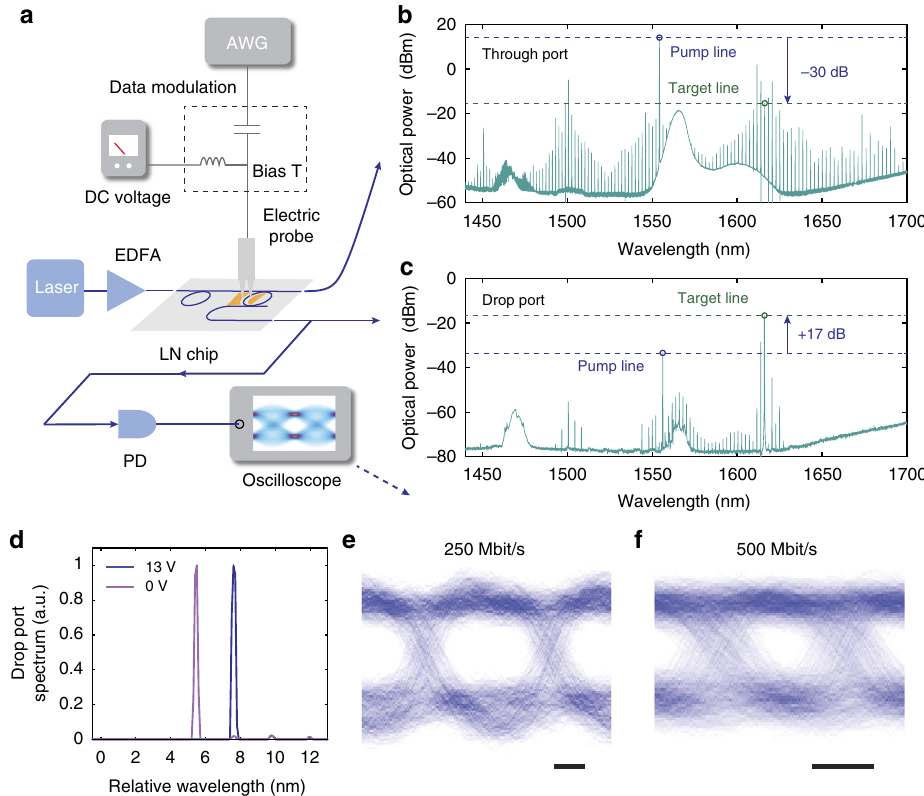
Fig. 3 On-chip fi ltering and modulation of a frequency comb. a Simpli fi ed characterisation setup. b , c Measured optical spectra at the through ( b ) and the drop ( c ) ports of the fi lter, picking out a target comb line at ~1616nm. The fi lter shows 47 dB suppression of the pump light. d Zoom-in view of the drop- port output spectra near the target line at different DC bias voltages. Applying a bias voltage of 13 V shifts the target from one comb line to the next one. e , f Applying AC electric signals could modulate the intensity of the selected comb line at 250 Mbit s − 1 ( e ) and 500 Mbit s − 1 ( f ). Eye diagrams are measured by sending a random-binary voltage sequence to the fi lter, and monitoring the real-time output optical power. Open-eye operations can be achieved for both bit rates. Scale bars: 1 ns. AWG arbitrary waveform generator, EDFA erbium-doped fi bre ampli fi er, PD